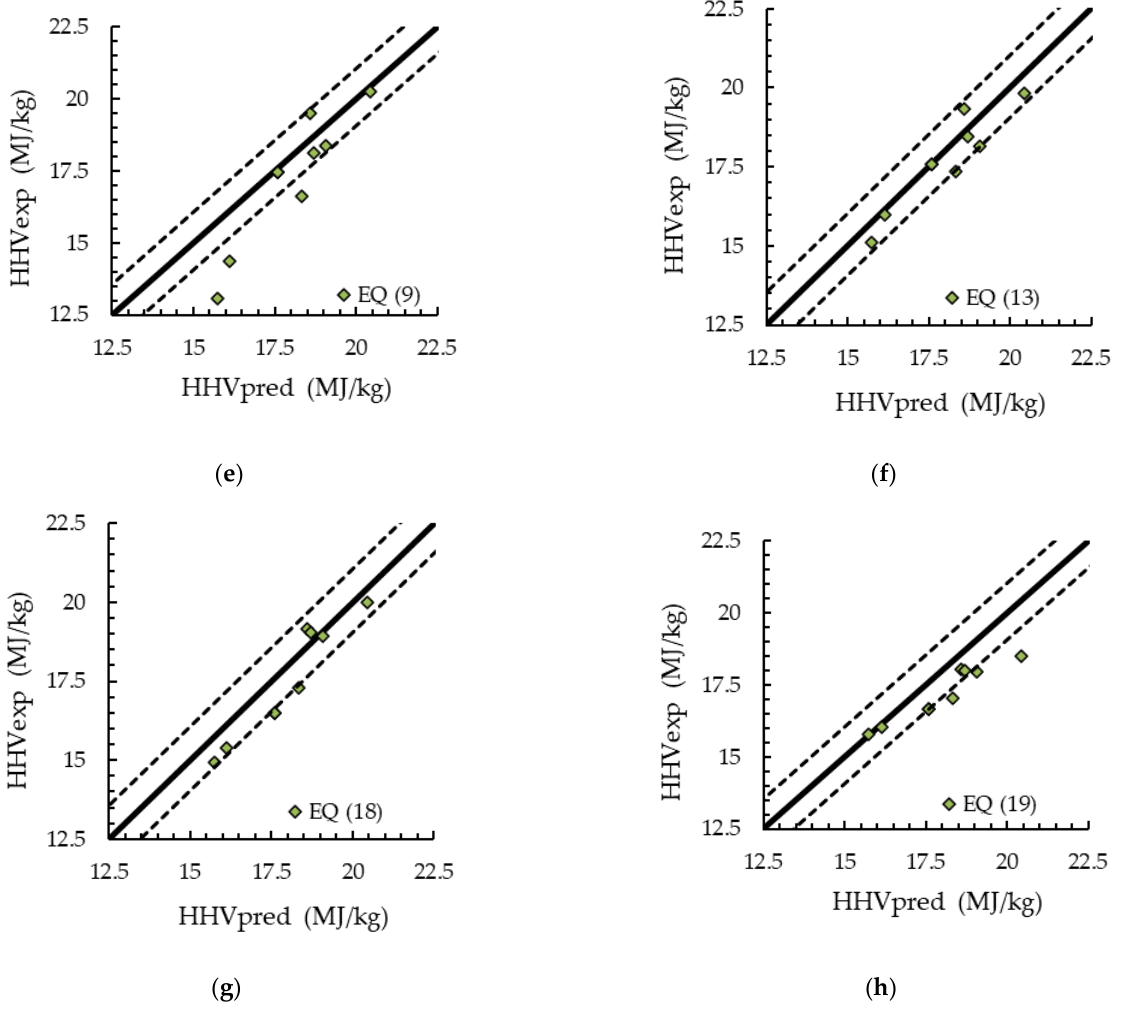
Figure 12. Comparison of the predicted and experimental HHV values based on ultimate analysis using different authors’ equations: ( a ) Equation (1); ( b ) Equation (2); ( c ) Equation (6); ( d ) Equation (7); ( e ) Equation (9); ( f ) Equation (13); ( g ) Equation (18) and ( h ) Equation (19).